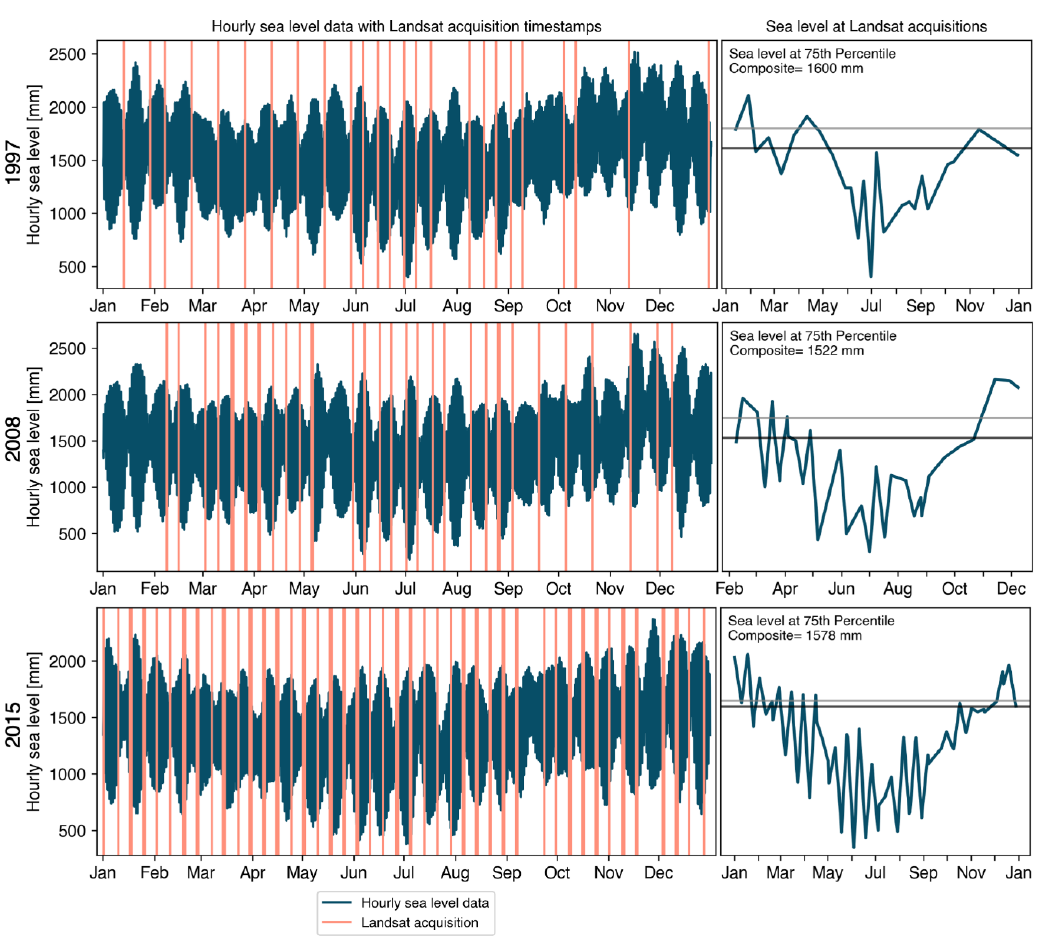
Figure 11. Left: Hourly sea levels at Qui Nhon station (blue) and Landsat acquisition times (orange). Right: Sea levels only at Landsat acquisition times (blue), 75th percentile of sea levels at Landsat acquisition time (black line), and 75th percentile of all sea levels (grey line).